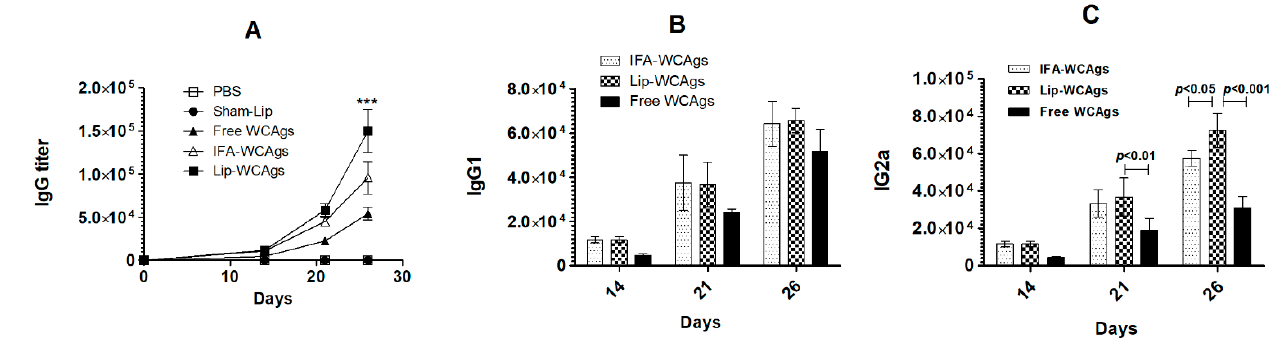
Figure 2. Mice immunized with Lip-WCAgs had higher levels of serum IgG and IgG2a. The levels of ( A ) IgG, *** ( p < 0.001) Lip-WCAgs vs. IFA-WCAgs ( B ) IgG1, and ( C ) IgG2a on days 14, 21, and 28 post-immunization. The data are expressed as mean ± SD of three values.